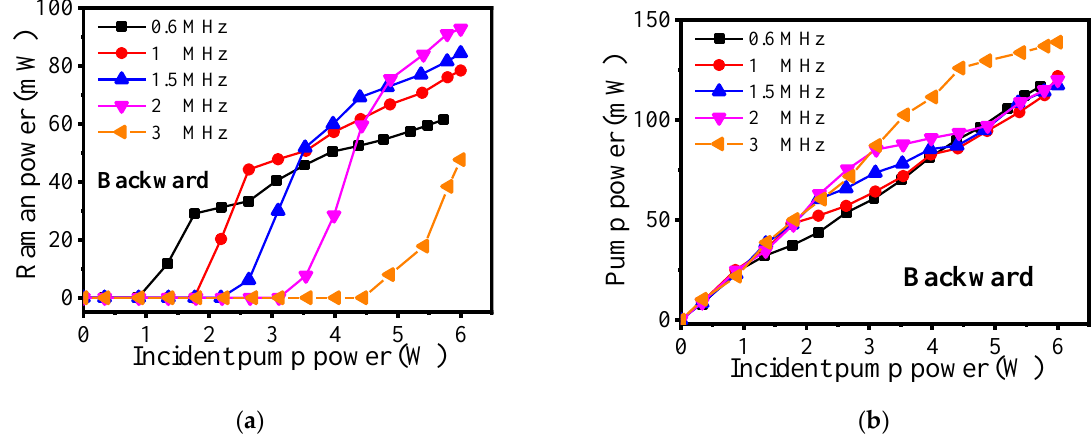
Figure 6. The characteristics of the backward output power with the incident pump power. ( a ) Raman power. ( b ) Pump power.